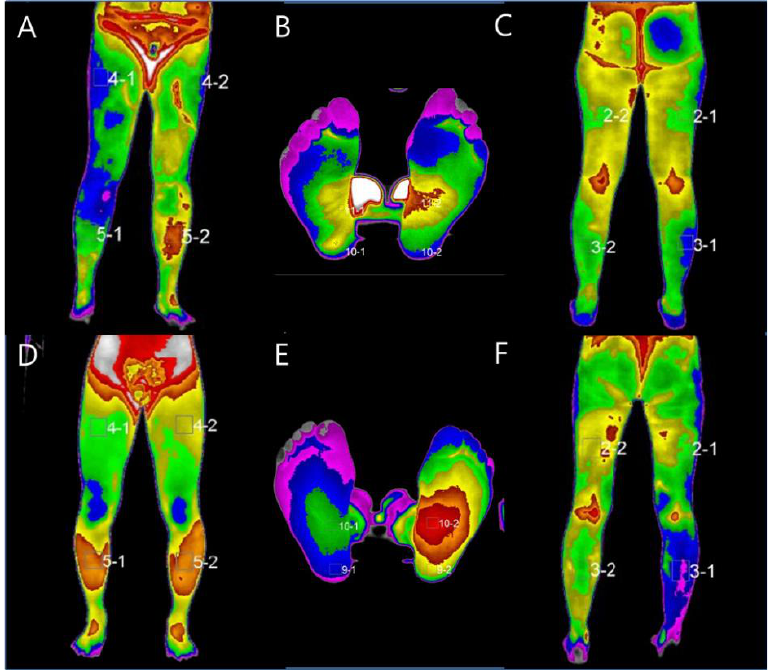
Figure 1. Representative DITI example and labeled sequences. HLD L4/5 patients undergoing DITI anterior ( A ), feet ( B ), and posterior ( C ) were labeled 1, 2, and 3 sequentially, respectively, and HLD L5/S1 patients undergoing DITI anterior ( D ), feet ( E ), and posterior ( F ) were labeled 4, 5, and 6, respectively.